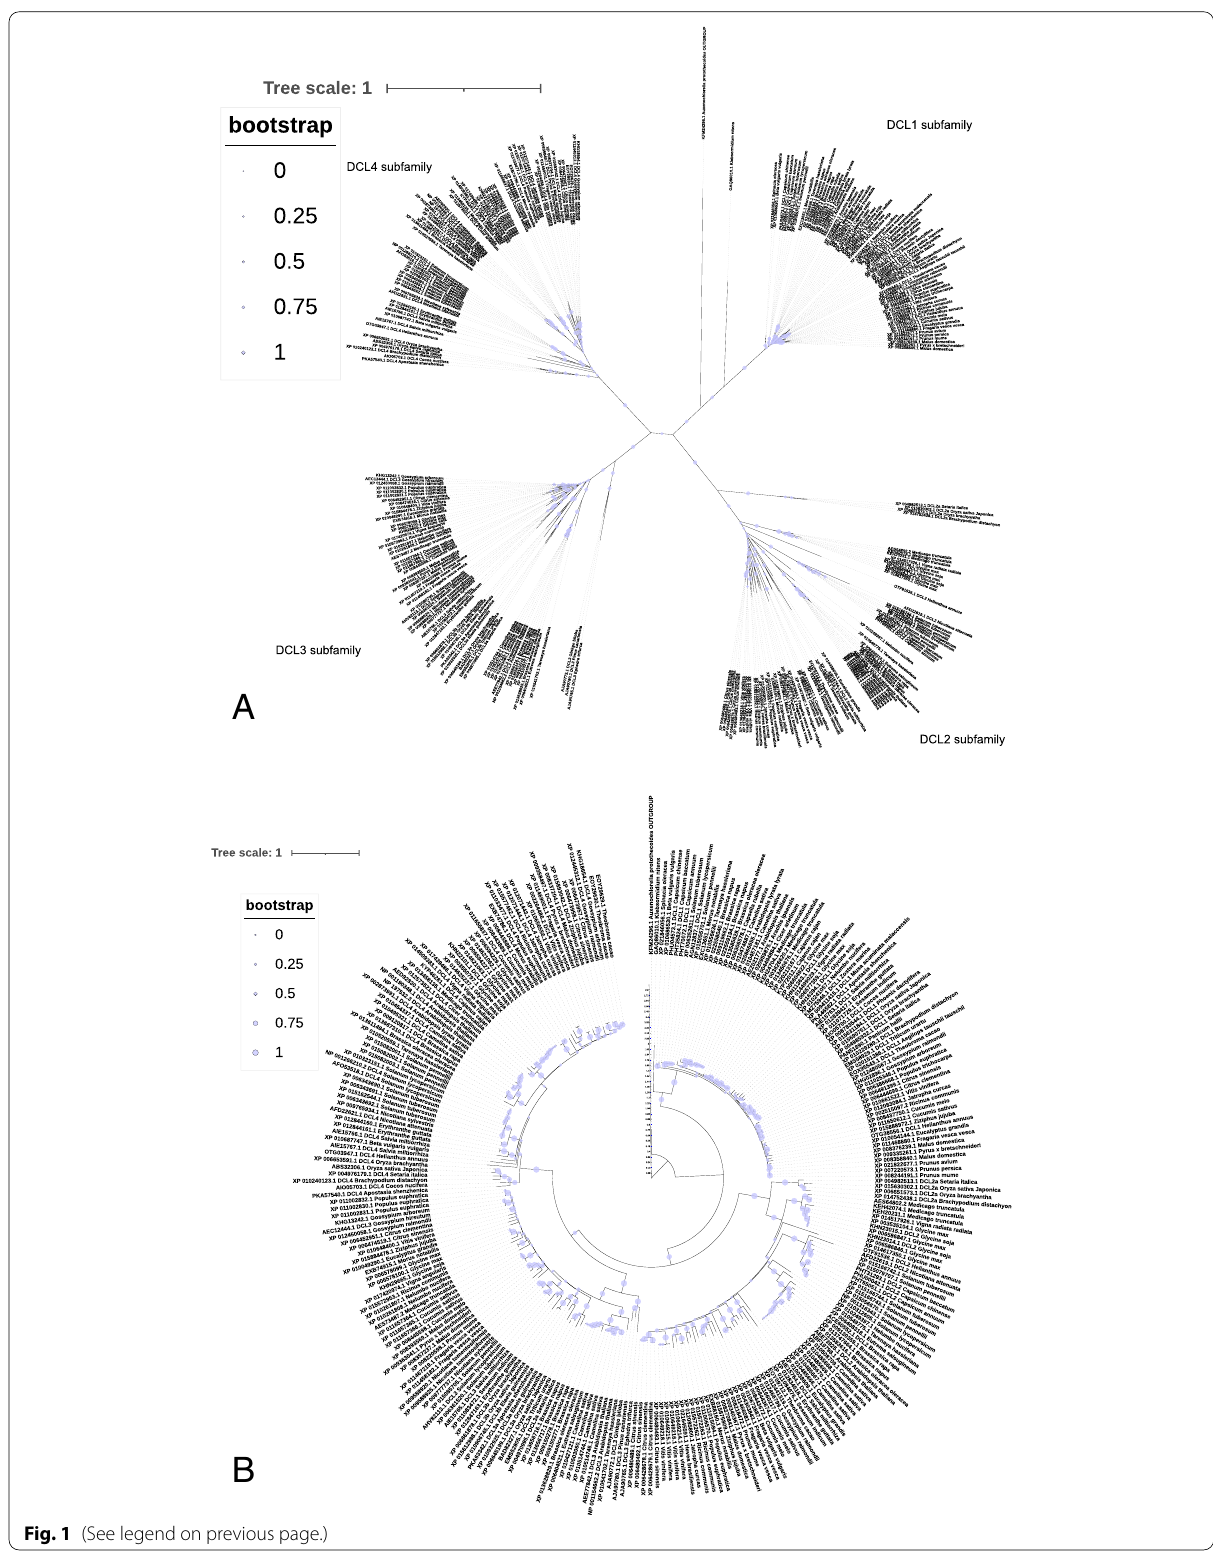
Fig. 1 (See legend on previous